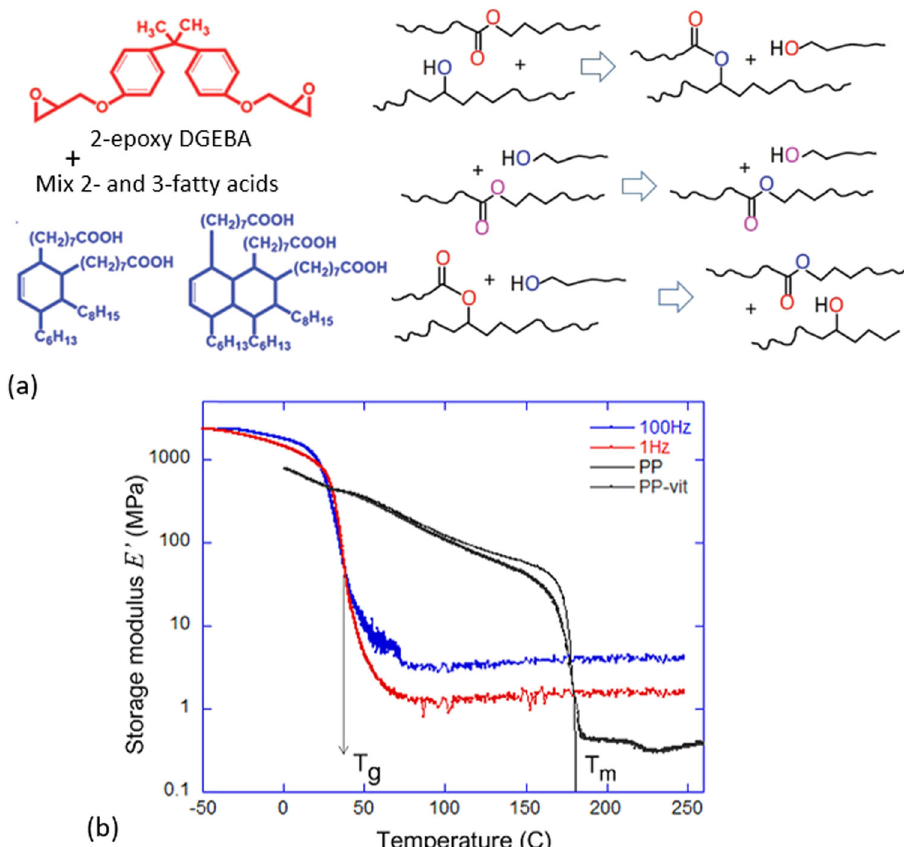
Fig.1|Thebenchamrkmaterialanditskeyproperties.a Thecomponentsofthe classicalLeibler'svitrimer:thedi-epoxyandamixof2-and3-functionalfattyacids, which bond into a cross-linked network at 130°C with 5% of zinc catalyst (see refs. 14, 45 for details). Also shown is the scheme of transesteri fi cation bond exchange, reachingtheequilibriumof2-2and1-3chaintopology. b Thetypicallineardynamic response of a vitrimer. The fi rst two curves show the storage modulus of the Lei- bler's benchmark epoxy vitrimer (at two frequencies of small oscillation), which